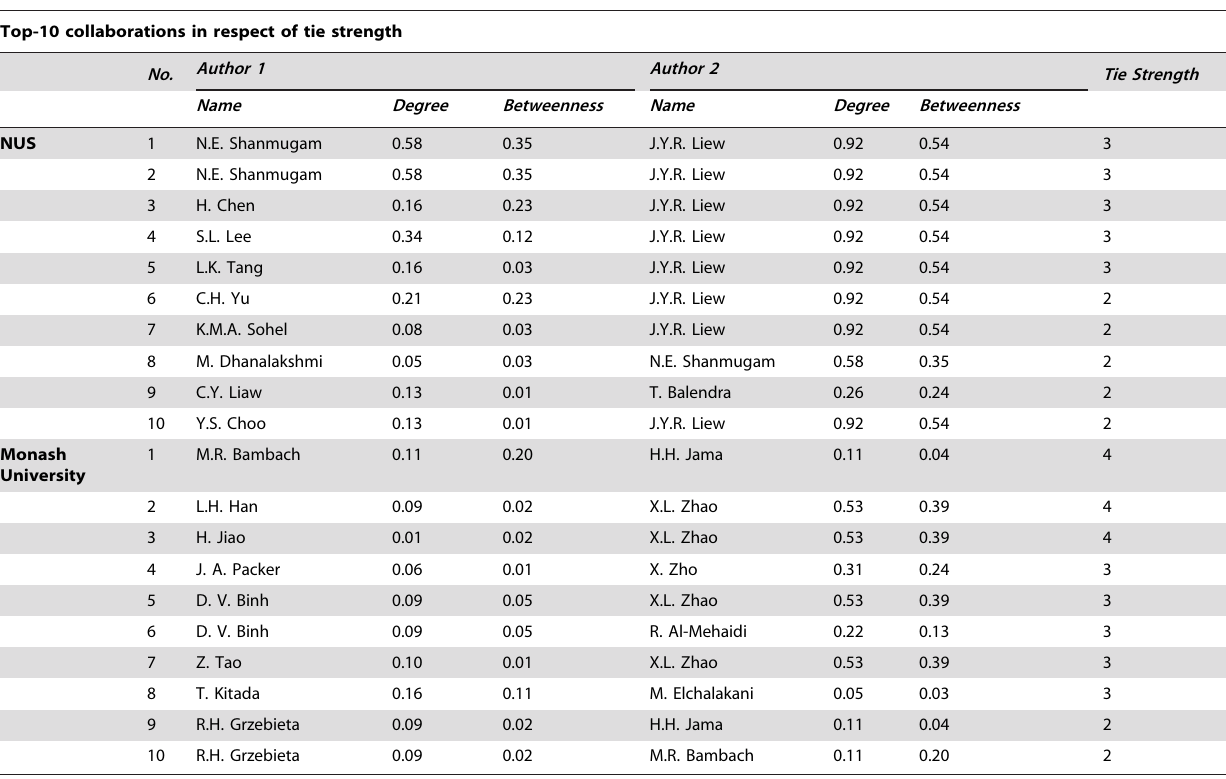
Table 6. Top-10 collaborations between authors (in respect of tie strength ) and scaled network measures (i.e., degree centrality and betweenness centrality ) of corresponding collaborators.